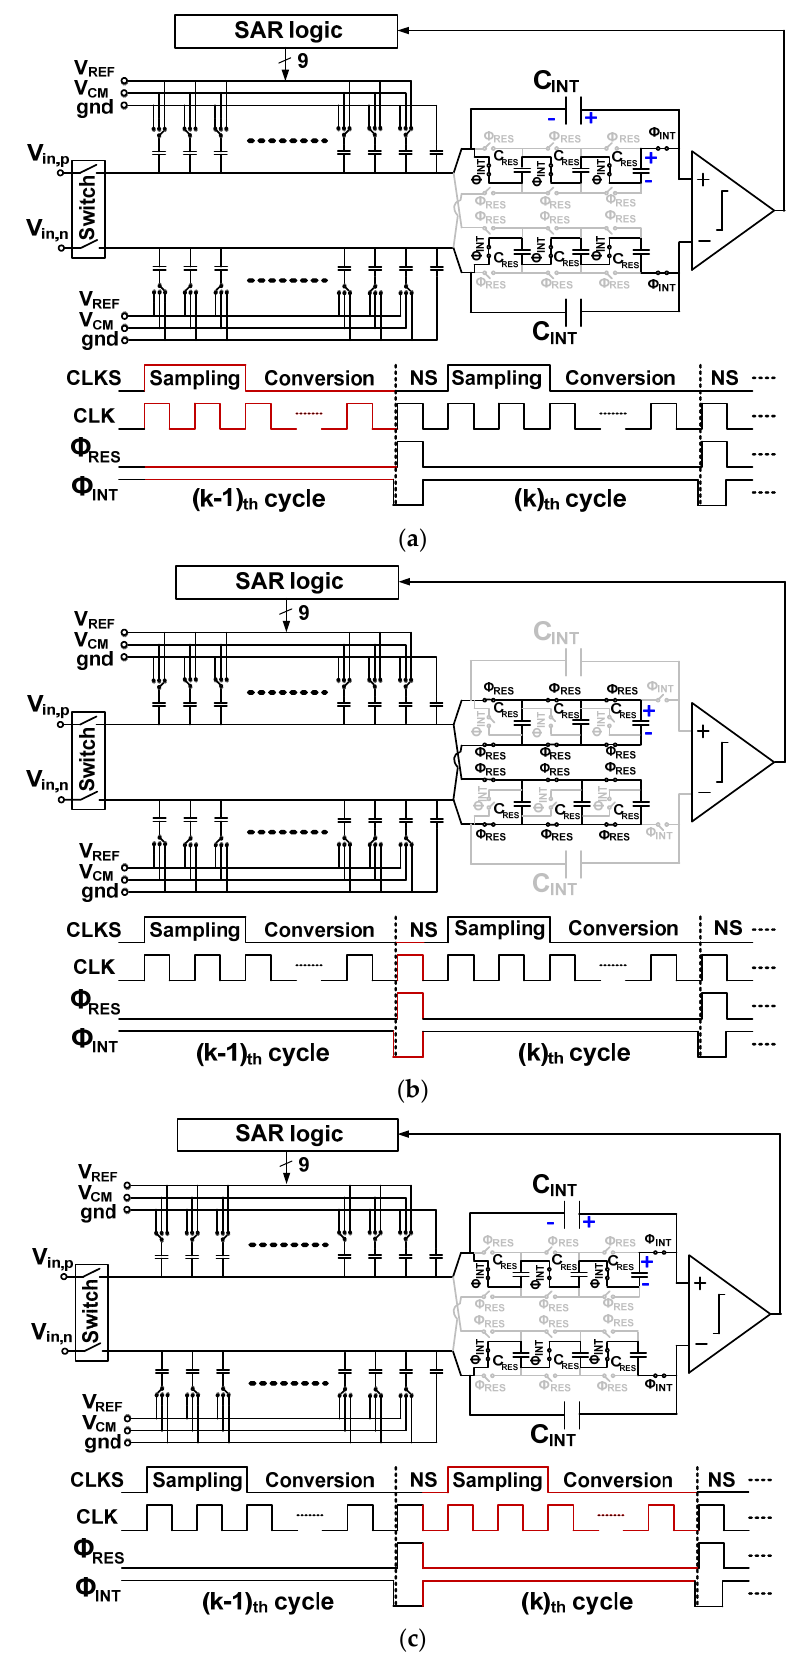
Figure 3. Operation of the noise shaping ADC. ( a ) ( k − 1) th cycle for sampling and digital conversion, ( b ) ( k − 1) th cycle for residue capture, and ( c ) k th cycle for charge pumping and residue integration.